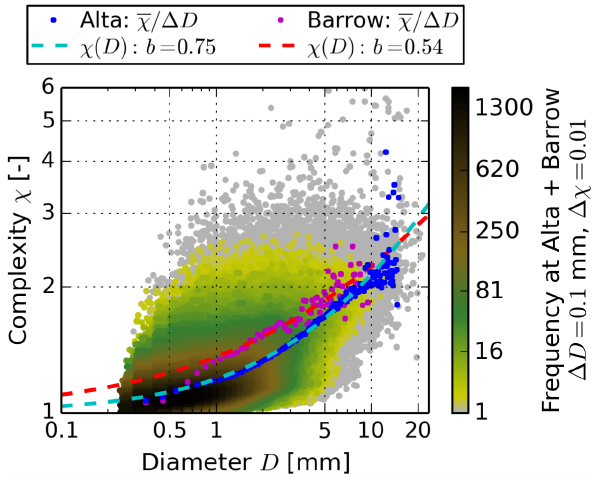
Figure 3. Logarithmic 2-D histogram for all MASC data of snowflake diameter D and complexity χ presented in Fig. 2, with bin sizes of (cid:49)D = 0 . 1mm and (cid:49)χ = 0 . 01. Mean complexity val- ues per size bin are indicated by χ/(cid:49)D for snowflake data recorded at Alta and at Barrow separately. Snowflake complexity–diameter relationships χ(D) for the data sets collected at Alta and at Bar- row are determined by the nonlinear least squares method for fitting Eq. (2) to the values of χ/(cid:49)D and characterized by the power-law exponent b